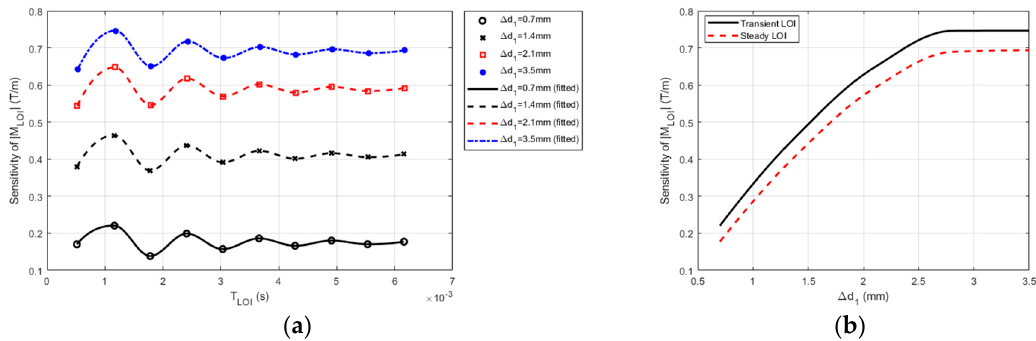
Figure 6. Sensitivities of the magnitudes of LOIs of PMEC signals vs. CLTL depth: ( a ) the sensitivity of M LOI vs. T LOI against ∆ d 1 ; ( b ) M LOI of the transient and steady LOIs against ∆ d 1.